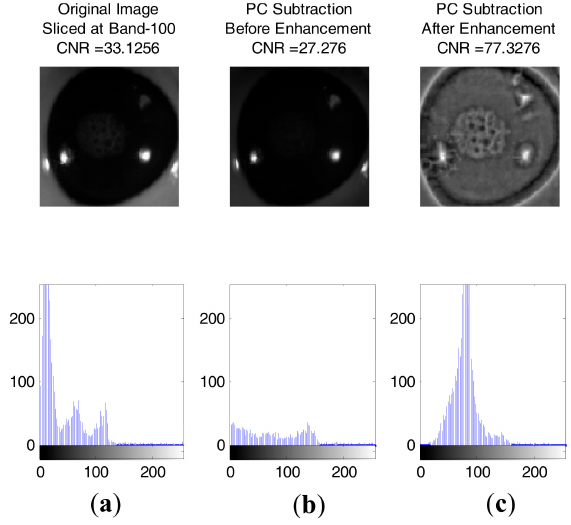
Figure 17. Image of healthy cornea with the histogram underneath respectively. Images were normalised and resized to 100by 100: ( a ) OriginalImage sliced atband-100 (CNR: 33.1256); ( b ) Imageafter PC subtraction before enhancement (CNR: 27.276); ( c ) Image after PC subtraction and enhancement (CNR: 77.3276).